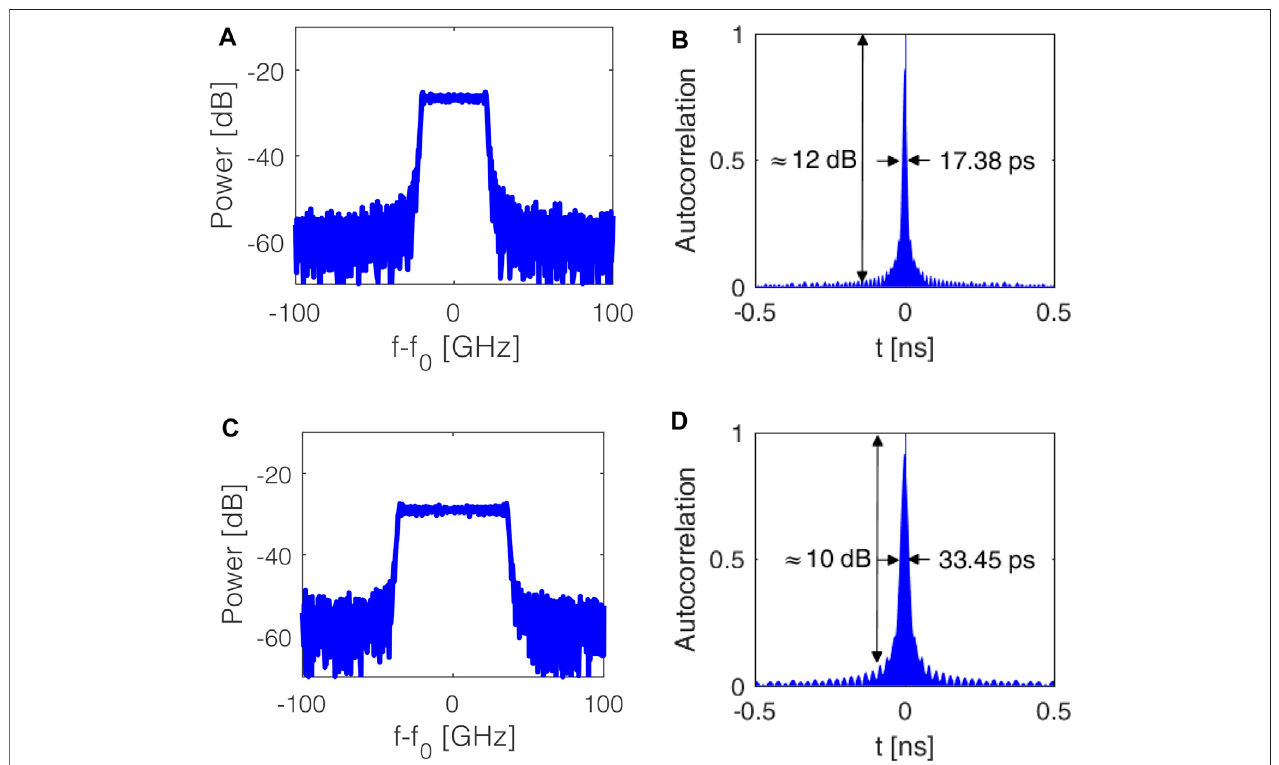
FIGURE 6 | RF spectrum and autocorrelation for N = 9 (A,B) , N = 18 (C,D) , by assuming M = 40, V pp = 1.1 V.